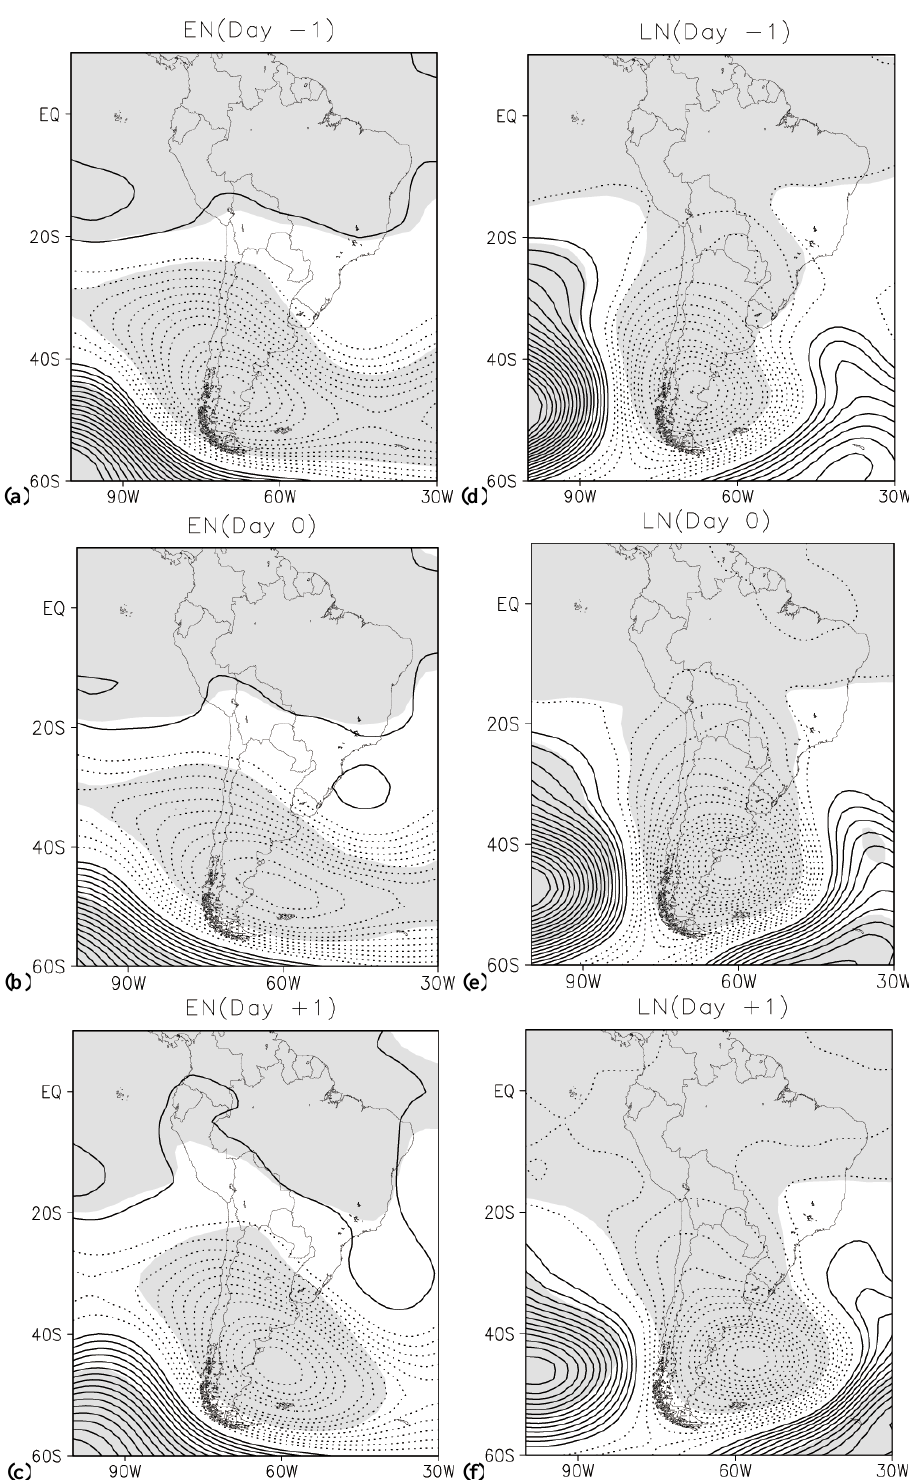
Fig. 5. Same as Fig. 4 but for the 500hPa geopotential height anomaly. Contour interval is 5m. Negative contours are dotted and the zero contours are omitted. Areas where anomalies are statistically significant at the 95% level are shaded in